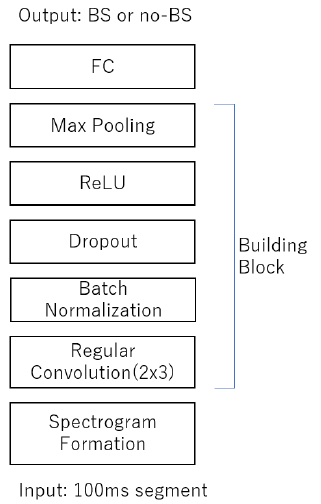
Figure 2. The 100 ms segment of spectrogram was fed to CNN building blocks where it consisted of two sets of three convolution layers, batch normalization, dropout, rectified linear unit (ReLU) activation function, max-pooling layer, and fully connected layer (FC).